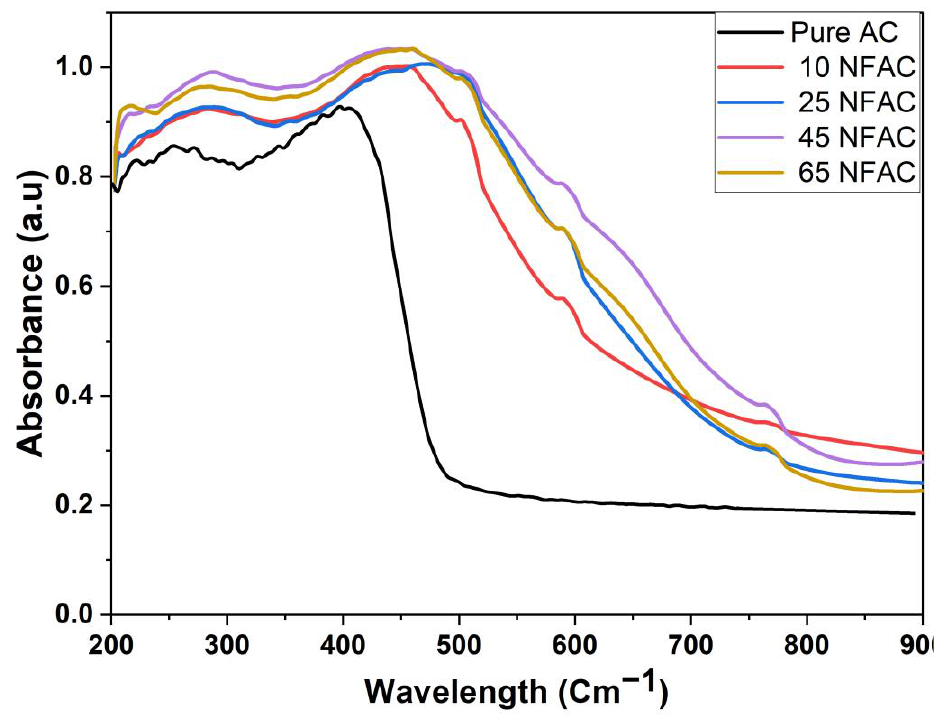
Figure 9. UV-Vis Diffuse Reflectance Spectroscopy of nickel ferrites with varying weight percentages in both pure and modified AC.